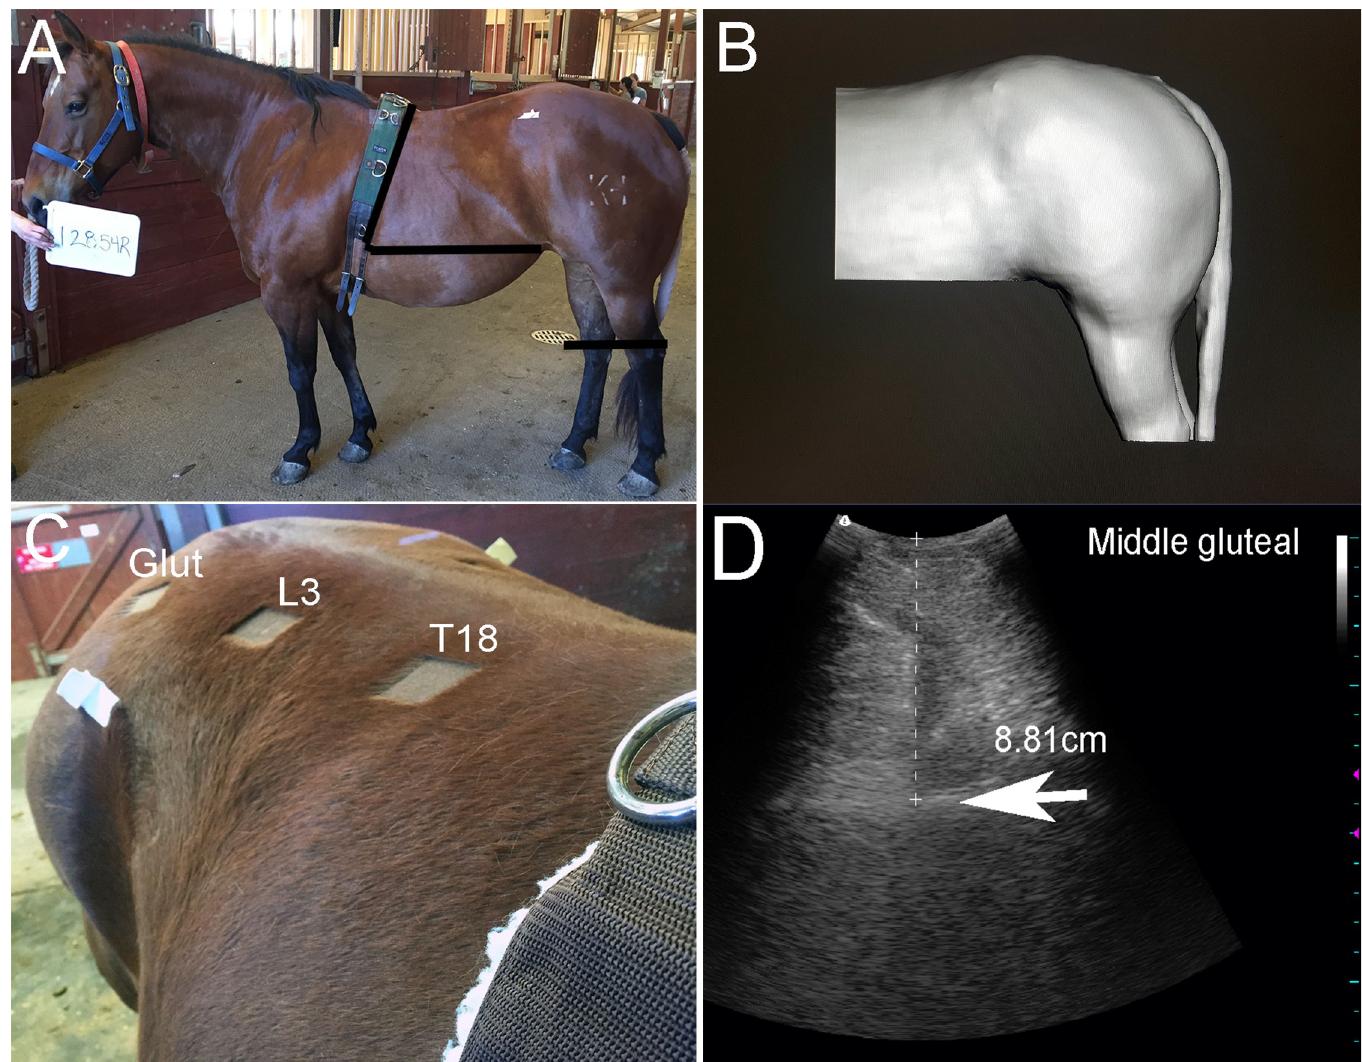
Fig 2. Torso and hindquarter volume cropping and processing of ultrasound images. A. Regions of the body that were cropped (black lines) in order to obtain the torso volume measurement. The torso was defined as the area caudal to the surcingle above a horizontal plane drawn parallel to the floor from the skin fold at the juncture of the stifle and flank and included the hindquarters above the point of the hock. B. The 3D image of the body scan of the torso of the horse in A. C. The 3 areas utilized for US imaging including T18, L3 over the longissimus muscle and middle gluteal muscle. D. US image of the middle gluteal muscle where muscle depth was measured for the superficial compartment. Arrow indicates fascia separating superficial and deep middle gluteal